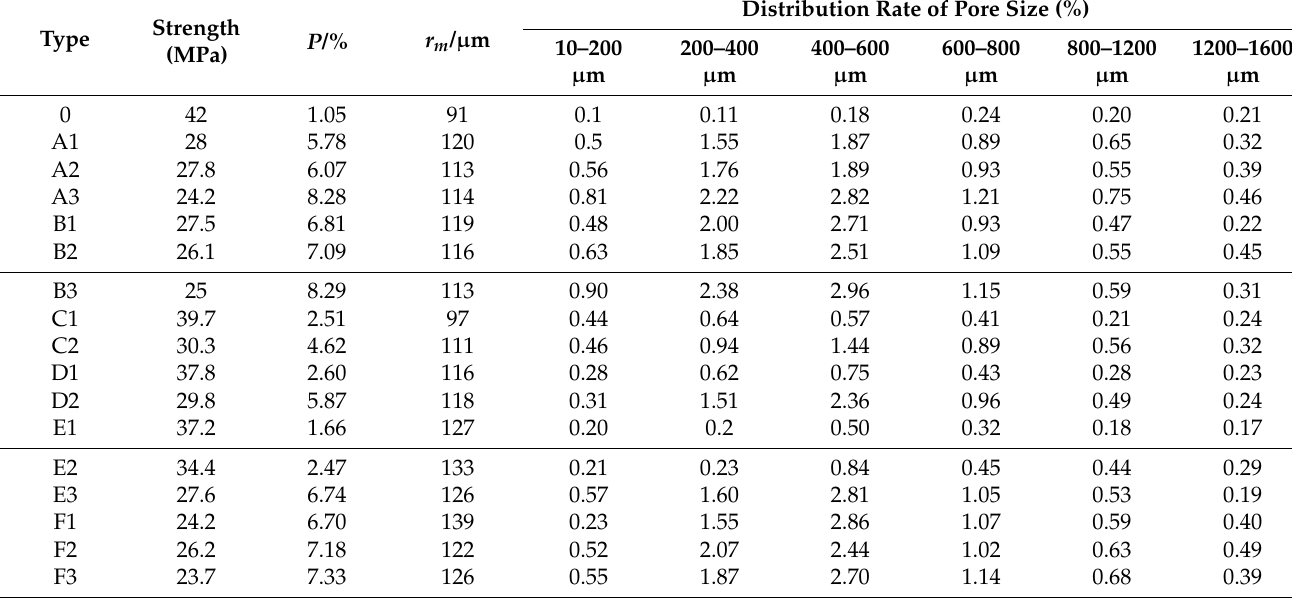
Table 3. Concrete parameters (data